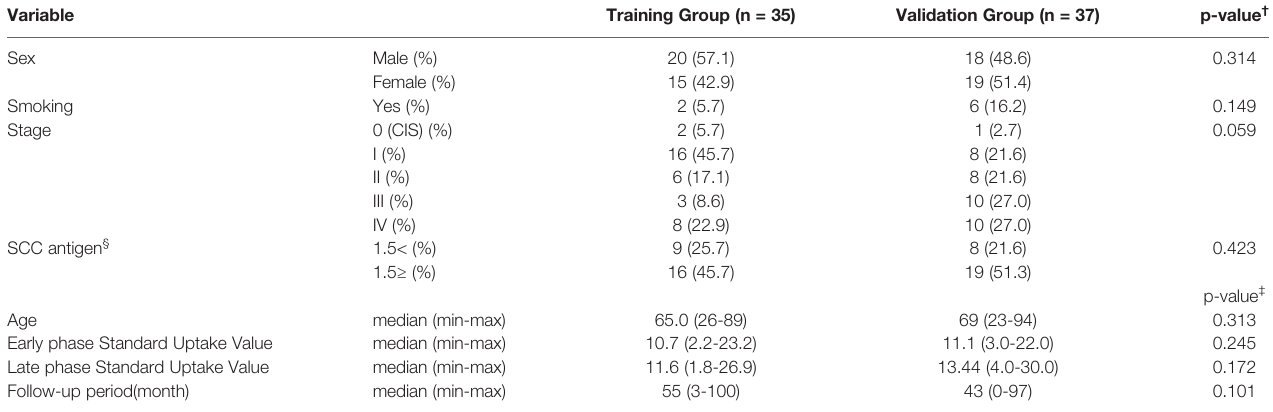
TABLE 1 | Characteristics of all participants (n =